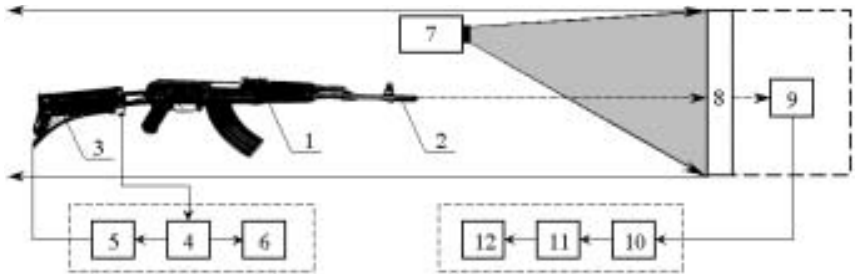
Fig. 8. The functional scheme of Laser riflemen trainer LT-2: 1 – training gun, 2 – infrared laser, 3 – pneumatic recoil simulation mechanism, 4 – control of laser, air and sound systems, 5 – compressed air supply system, 6 – shot sound simulation system, 7 – video projector, 8 – target screen, 9 – video camera, 10 – PC (data processing system), 11 – monitor, 12 – printer.